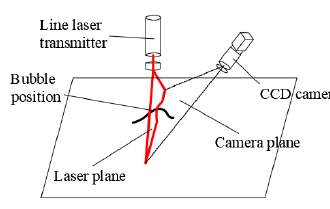
Figure 1. Position relationship between camera and line laser transmitter.